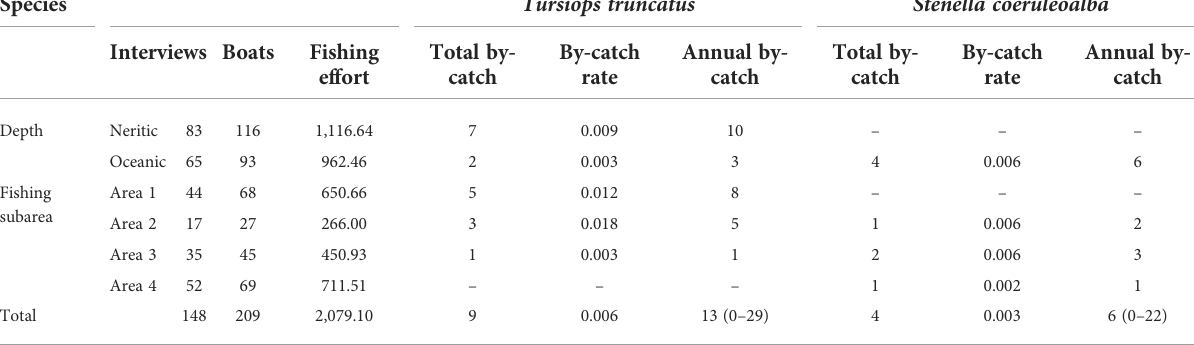
TABLE 2 By-catch of Tursiops truncatus and Stenella coeruleoalba reported by bottom trawling vessels according to depth zones (neritic/ oceanic), fi shing subareas (1 – 4), and totally. The summary of total reported by-catch individuals, by-catch rates, and annual cetacean